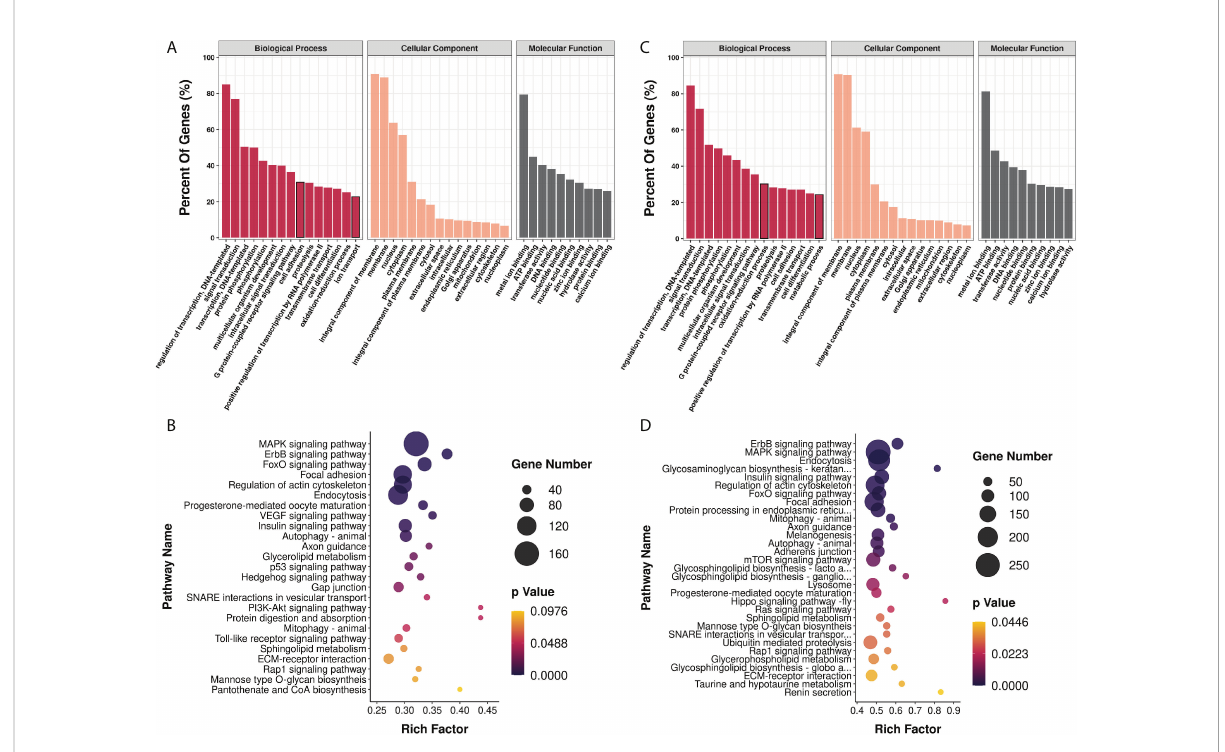
FIGURE 4 Functional analysis of genes targeted by exosomal miRNA candidates by GO and KEGG enrichment. GO (A) and KEGG (B) enrichment analysis of 5193 genes predicted to be targeted by high level miRNAs with signi fi cant differences between control and infection groups; GO (C) and KEGG (D) enrichment analysis of 9266 genes predicted to be targeted by high level miRNAs with signi fi cant differences between early and late infection